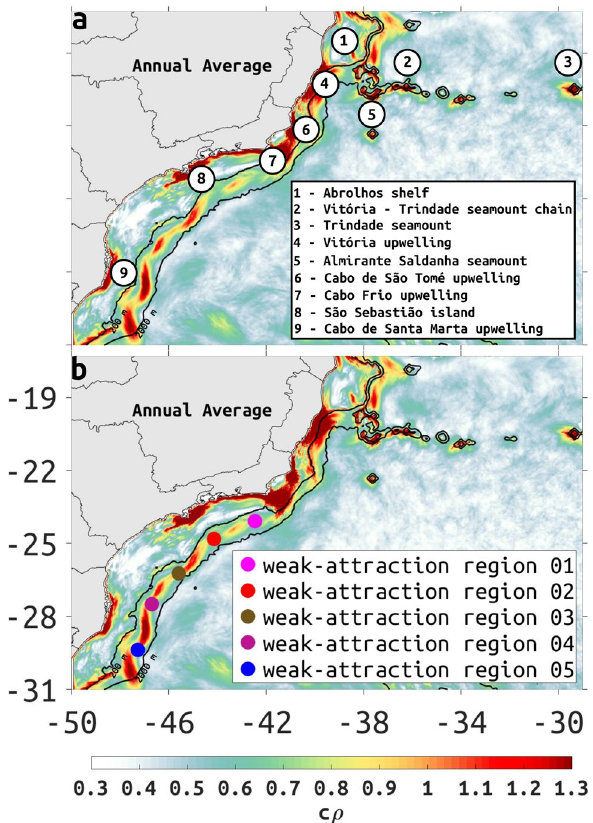
Figure 3. Climatological attraction c ρ (colors, logarithmic scale), computed by yearly averaging 7-day CG tensors from the 2003–2015 climatology, showing ( a ) locations with high values of annual mean c ρ ( > 1, 2.7 in linear units) and ( b ) regions of weak attraction adjacent to the 2000-m isobath (colored dots).The 200- and 2000-m depth contours are represented by black lines. Created with Matlab R2018B (www.mathw